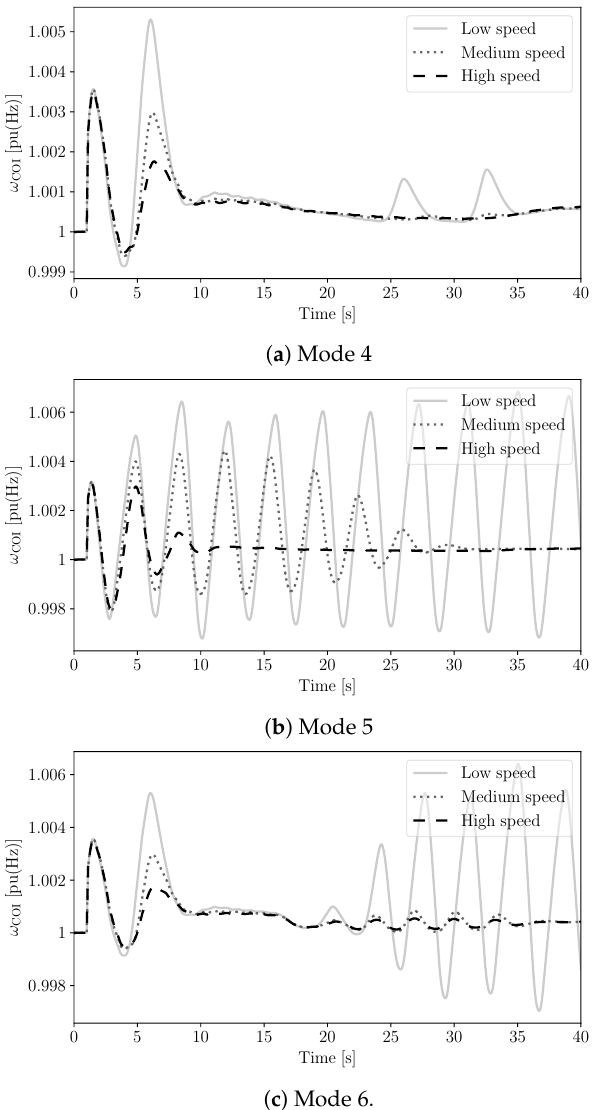
and p inj are POC